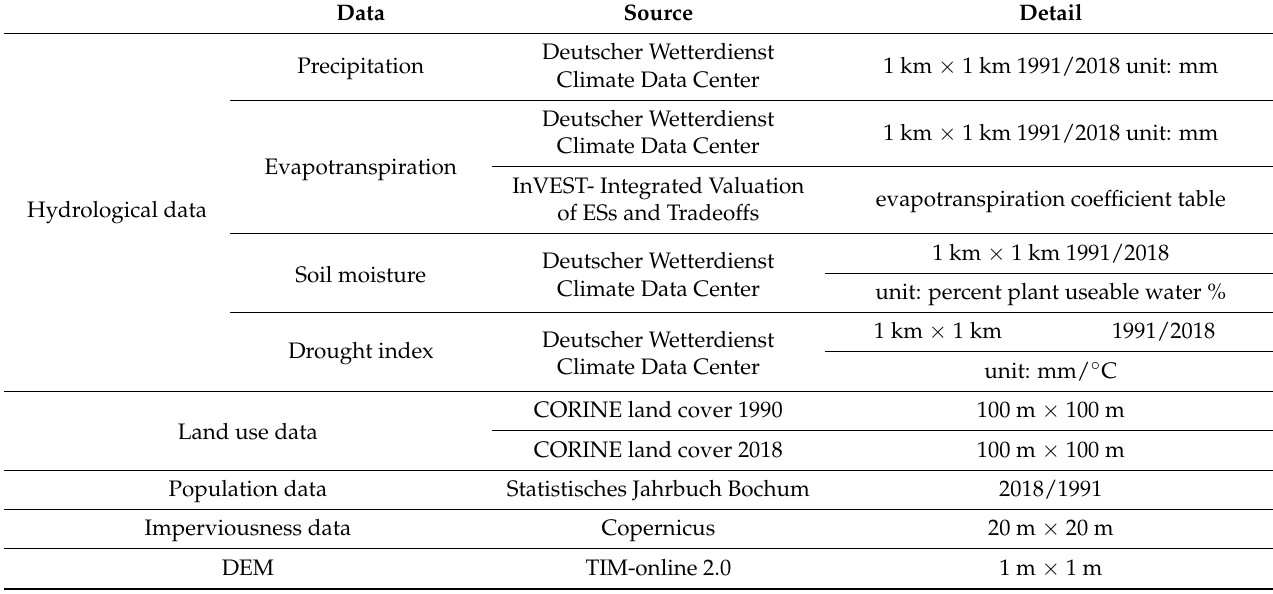
Table 2. Utilized data, their source, and their spatial resolution for the study